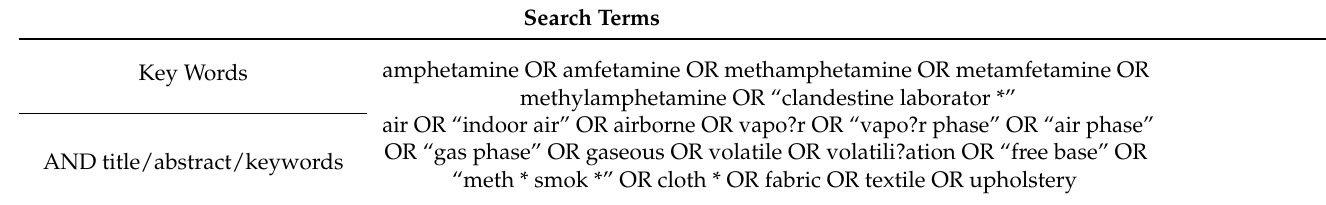
Table 1. Search terms and keywords used to identify relevant literature from databases Scopus, Web of Science, PubMed, and Google